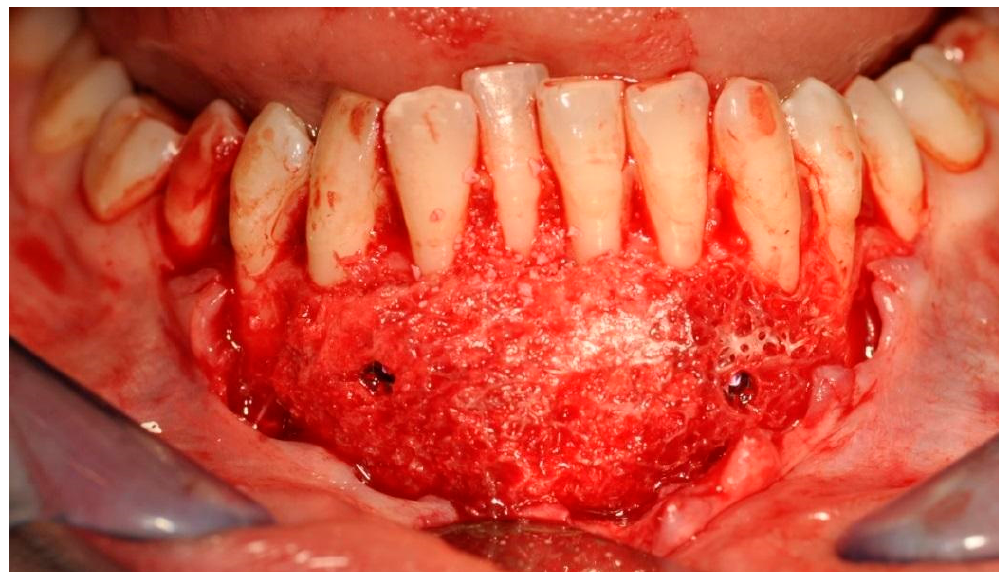
Figure 6. Individualized allogeneic bone block soaked in injectable platelet-rich fibrin before placement. In order to immobilize the bone block, and for its appropriate adaptation to the base, two 11 mm long resorbable polylactaic pins were ultrasonically introduced using the Son- icWeld Rx ® technique (KLS Martin, Jacksonville, FL, USA). Titanium screws can be used instead of resorbable pins, but should be removed after 6–8 weeks. Screws of about 8 mm long are usually used, i.e., Surgident Co (Daegu, Korea) [Figure 7].